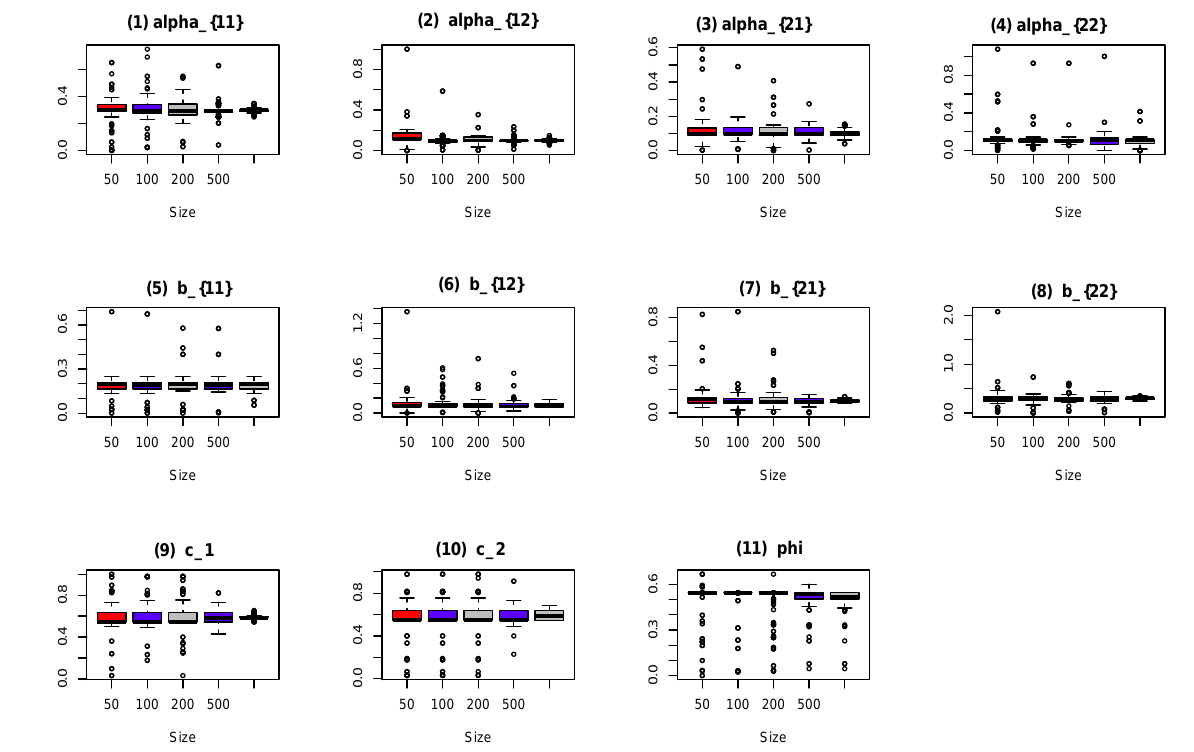
Figure 1. Boxplots of the CML estimates for non-diagonal EBINAR(1) model.